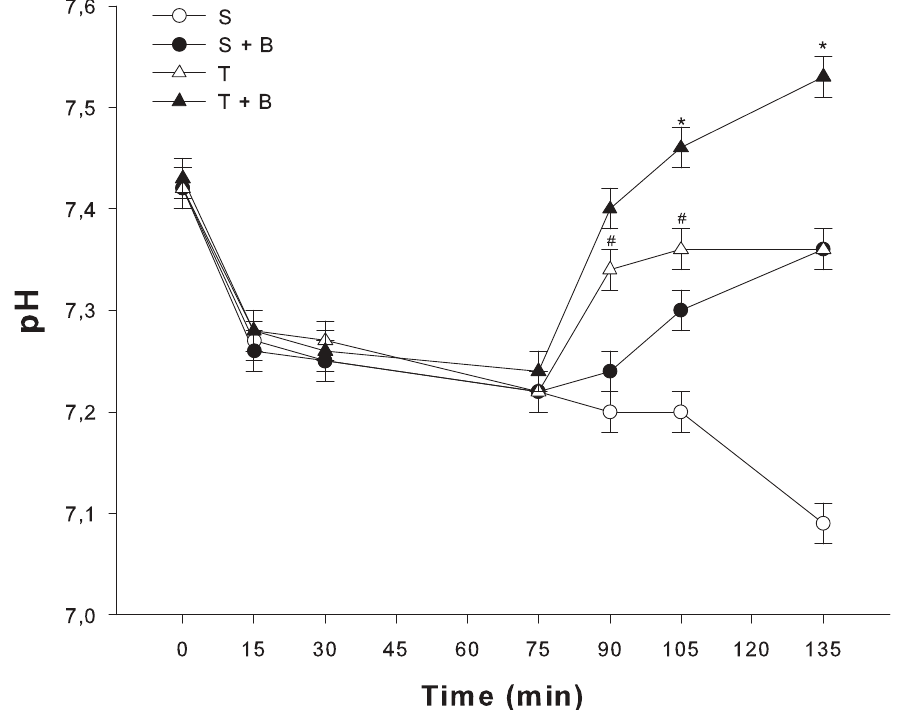
Figure 3. Blood pH over time in the four groups. After 75 minutes of infusion of lactic acid blood pH drop in all groups ( # P , 0.05 vs. time 0). At 135 minutes pH normalized in the transient group (T) while overshoot to alkalemic values when animals received NaHCO 3 (T + B). In the sustained group (S) pH continued to drop while alkaline infusion (S + B) resulted in correction of acidosis. u P , 0.05 vs time 75; * P , 0.05 vs. control.